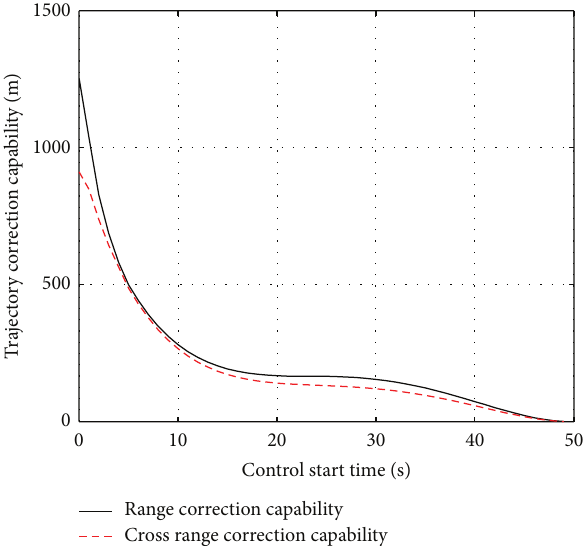
Figure 11: Trajectory correction capability versus control start time (using the optimized method).